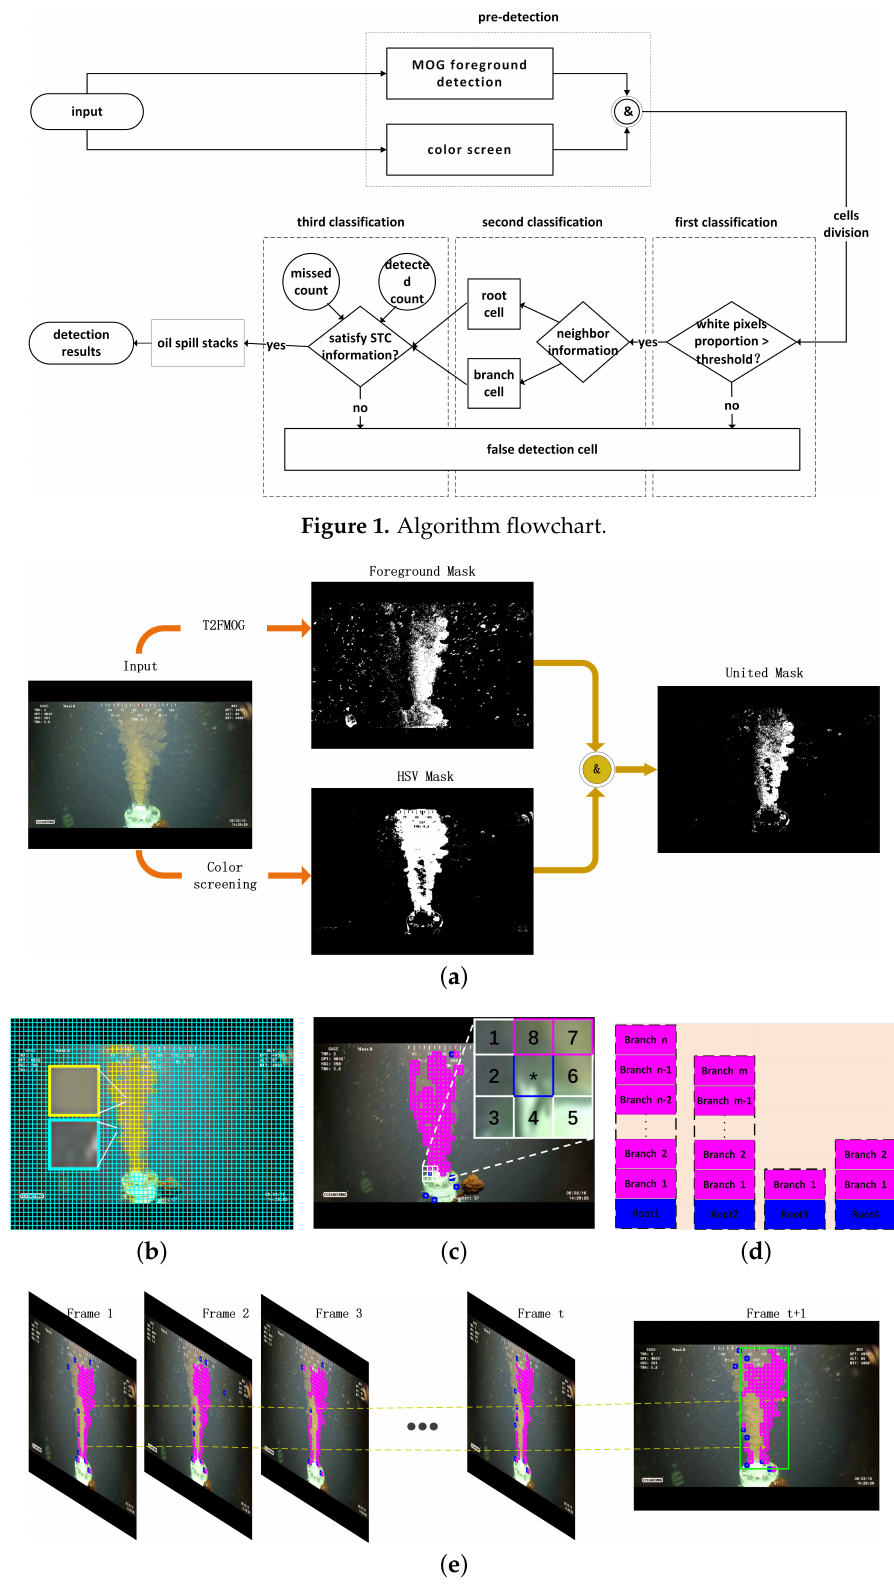
Figure 2. Algorithm implementation: ( a ) pre-detection; ( b ) cells division; ( c ) first classification; ( d ) second classification and ( e ) third